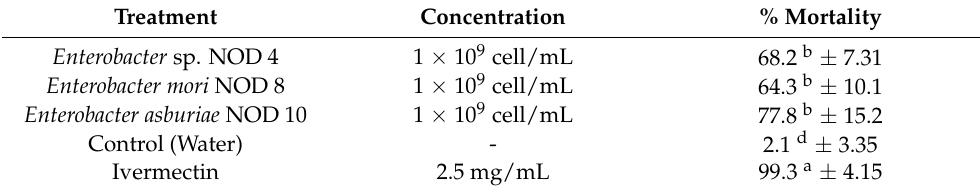
Table 4. In vitro evaluation of Enterobacter strains against Tyrophagus putrescentiae . Treatment